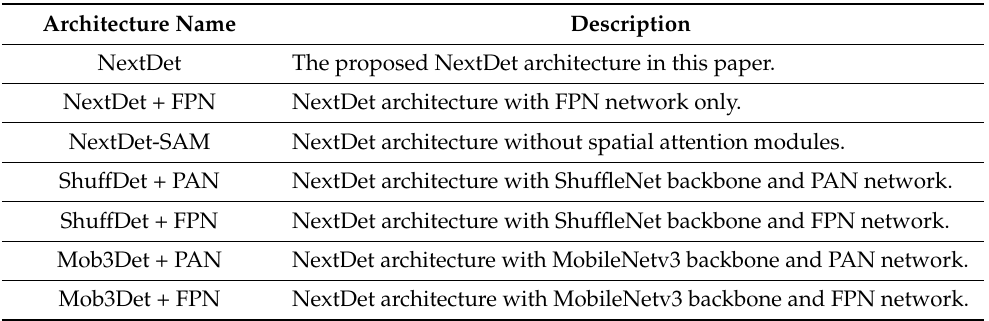
Table 5. A summary of acronyms of different versions of object detection architectures utilized in training and analysis